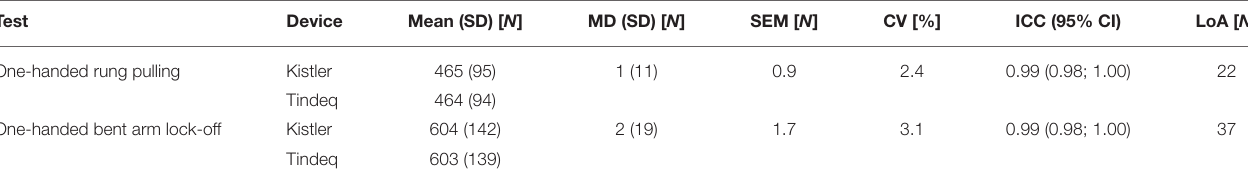
TABLE 2 | Validity and reliability indicators for the comparison between Tindeq vs . Kistler in the free condition. Test